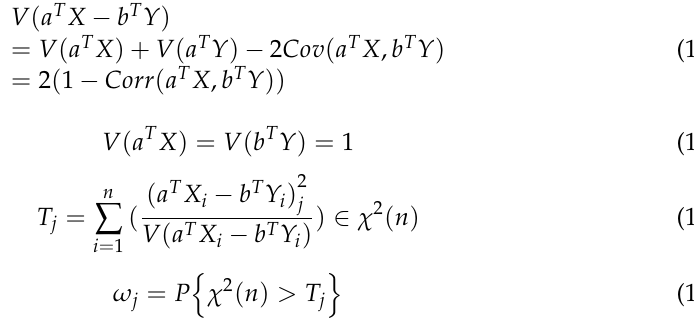
Figure 3. Alterations in pixel distribution: ( a ) before USFA, ( b ) under USFA, and ( c ) after USFA.